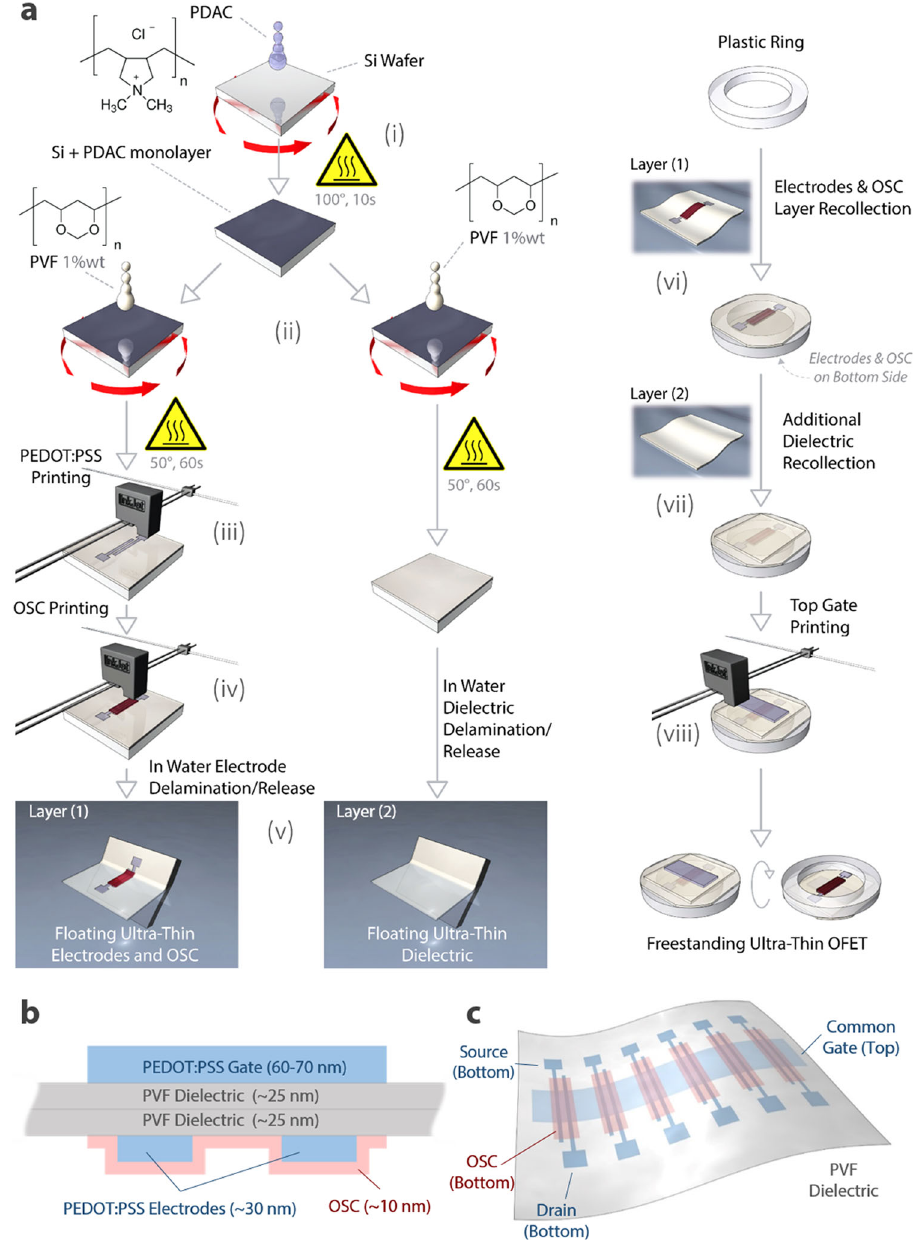
Fig. 1 Schematic representation of the fabrication process and of the structure of ultraconformable solution-processed transistors. a Fabrication process fl ow for all-organic ultrathin OFETs: (i) PDAC spin-coating, (ii) layer-1 and layer-2 PVF spin-coating, (iii) ink-jet printing of PEDOT:PSS source/ drain electrodes on layer-1, (iv) ink-jet printing of the organic semiconductor onto the electrodes over layer-1, (v) layer-1 and layer 2 delamination in water, (vi) layer-1 recollection on a plastic ring, (vii) recollection of layer-2 on layer-1, (viii), ink-jet printing of PEDOT:PSS gate electrodes. b Lateral view scheme and c overview of the ultrathin all-organic